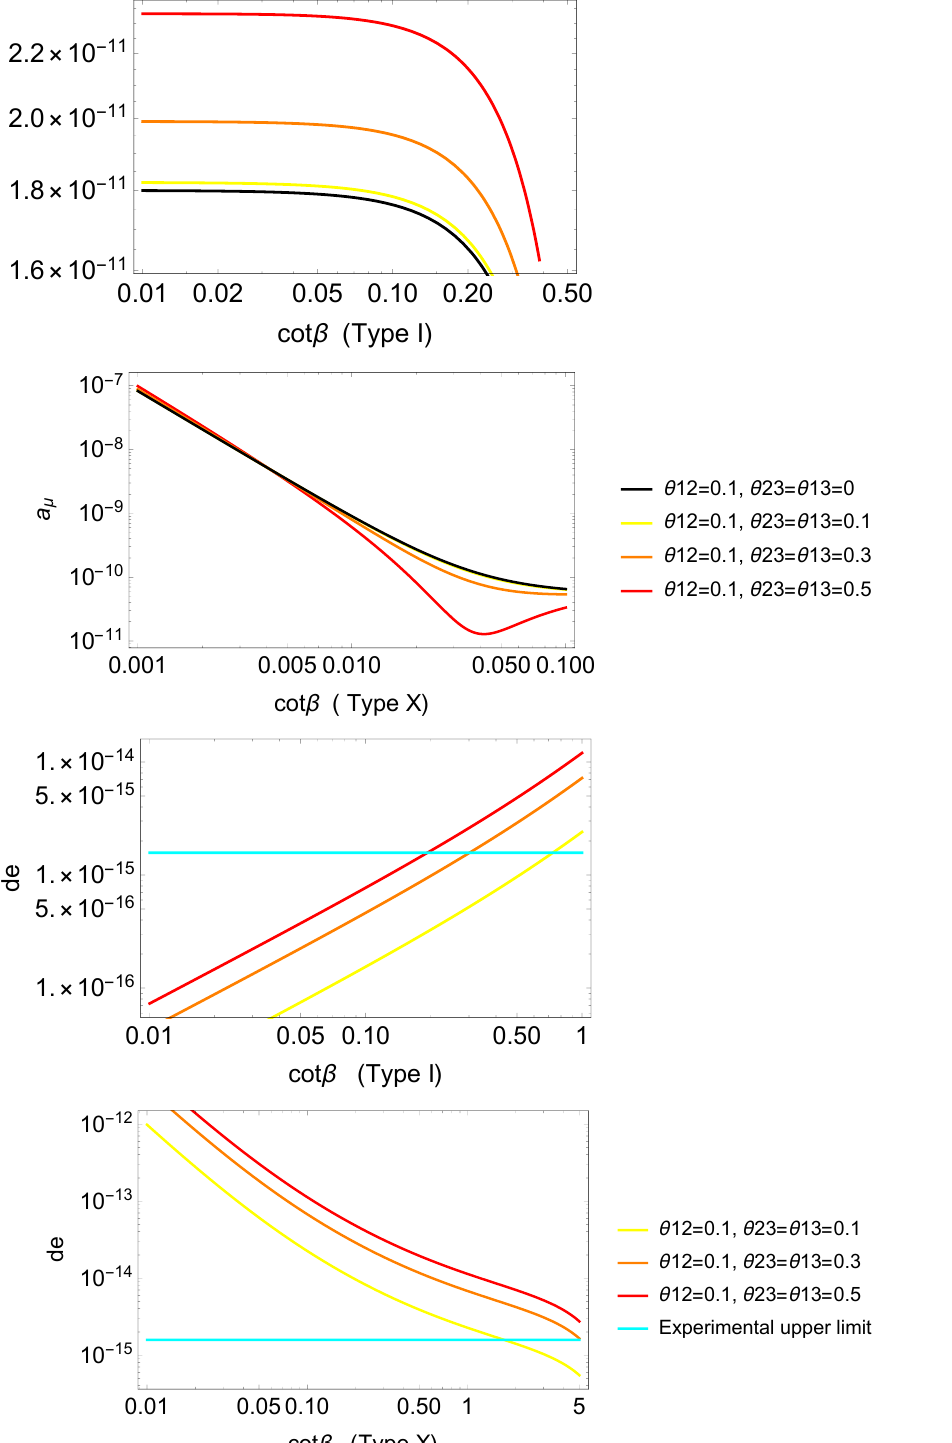
Figure 10 . a (cid:22) (top) and d e (bottom) values in Type I and Type X for di(cid:11)erent values of angles and (cid:12)xed values of masses ( m h = 145 ; 105 GeV). The behaviour of Type Y and II are similar to 2 ; 3 Type I and X,